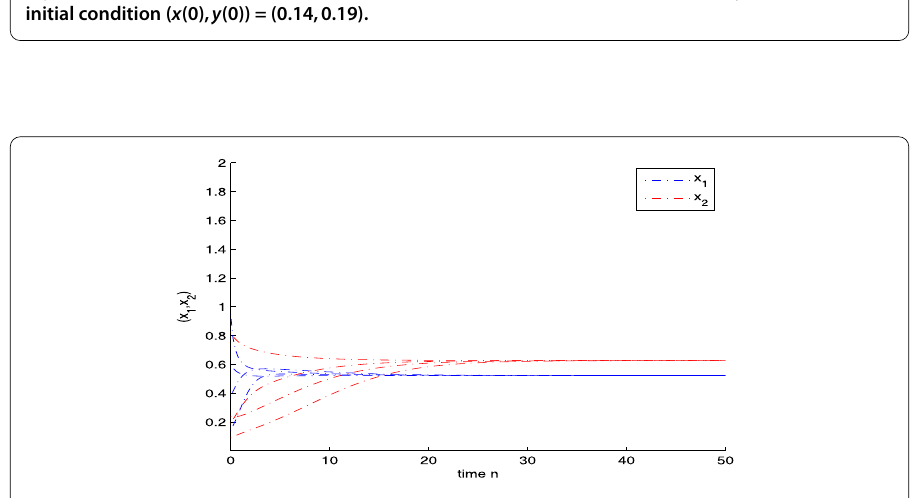
Figure 6 Numeric simulations of system (4.3) with initial conditions ( x (0), y (0)) = (0.14,0.19),(0.37,0.009),(0.95,0.024), and